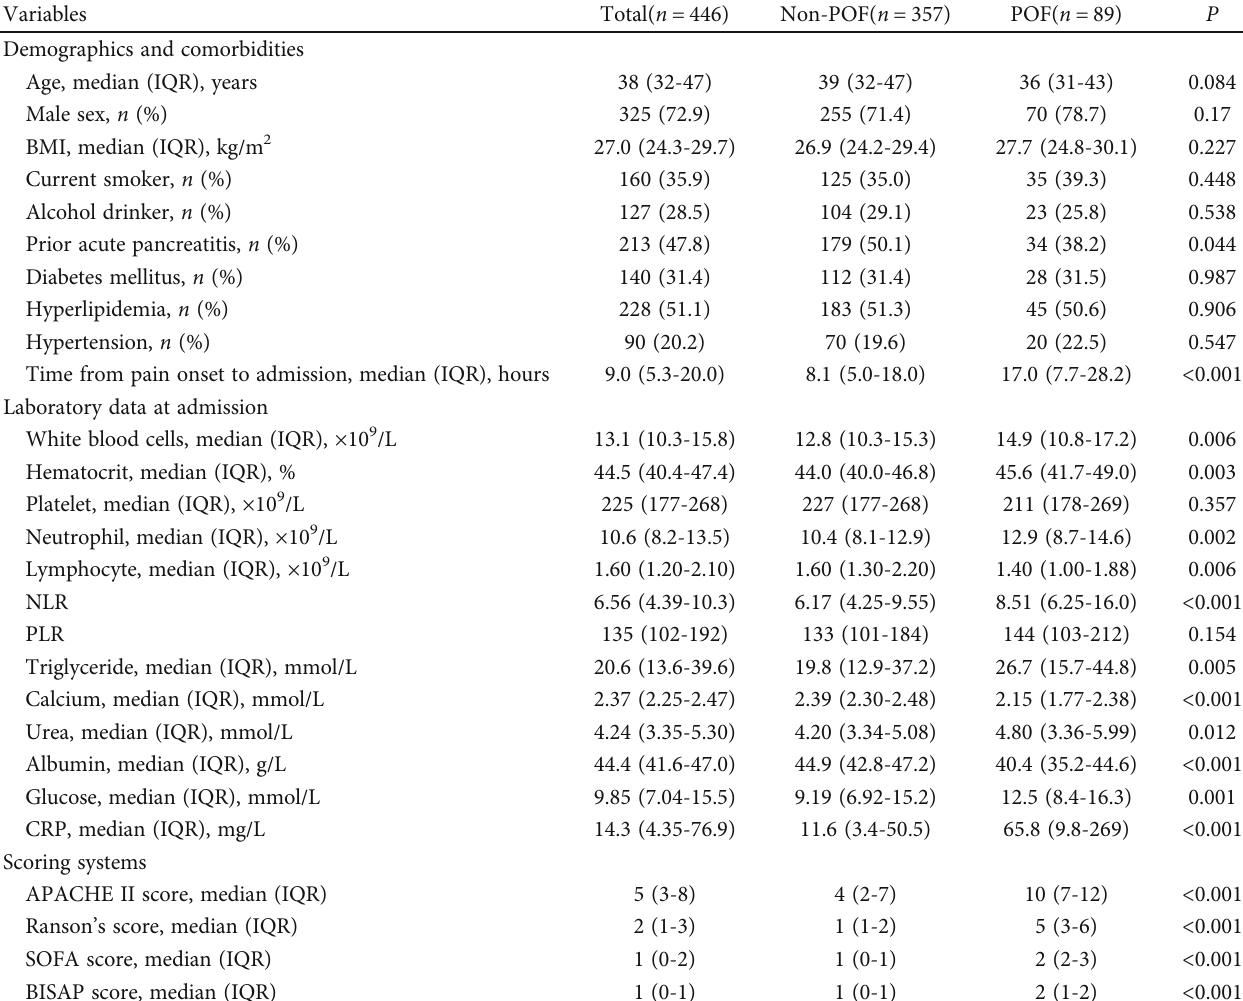
Table 1: Demographic and clinical characteristics according to the occurrence of